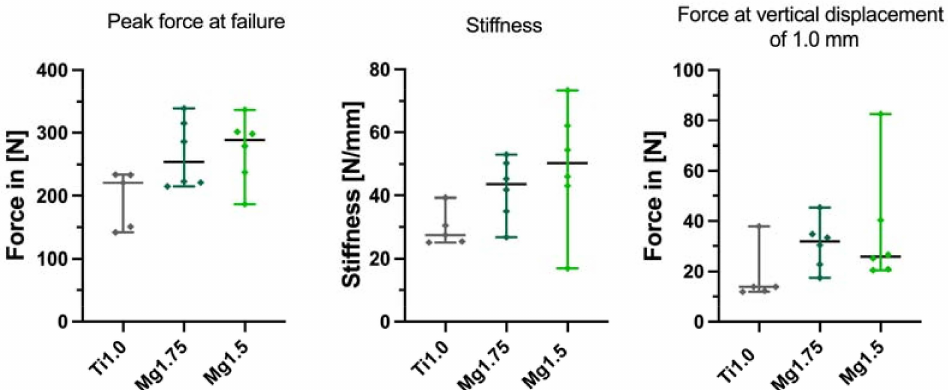
Figure 3. Peak force at failure, stiffness determined in the area of 100 N to 125 N, and force at vertical displacement of 1.0 mm are illustrated. Comparisons of titanium 1.0 mm (Ti1.0), magnesium 1.75 mm (Mg1.75), and magnesium 1.5 mm (Mg1.5) are presented with medians with 95% CI.